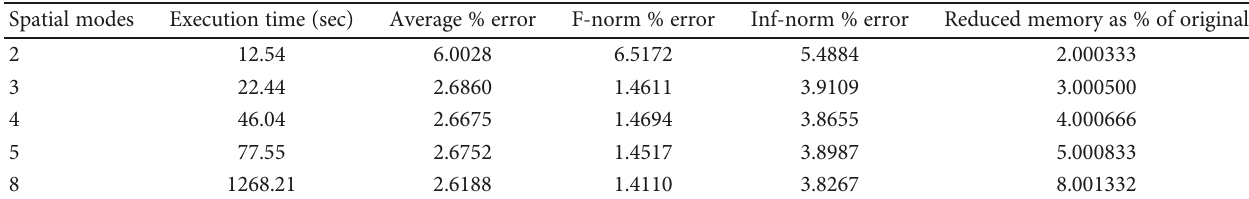
Table 15: Stagnation energy reduced 3D model over 100 time